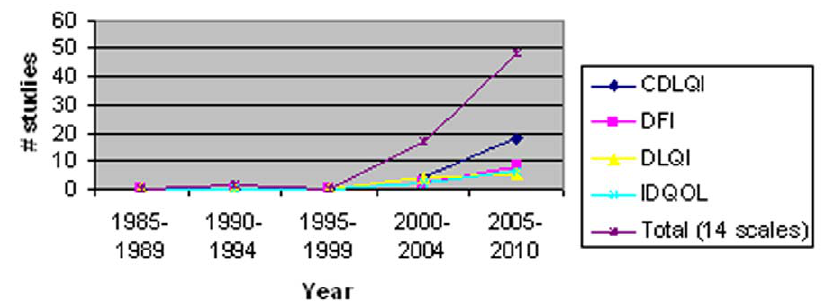
Figure 3. Trends in Quality of Life Instruments 1985–2010.